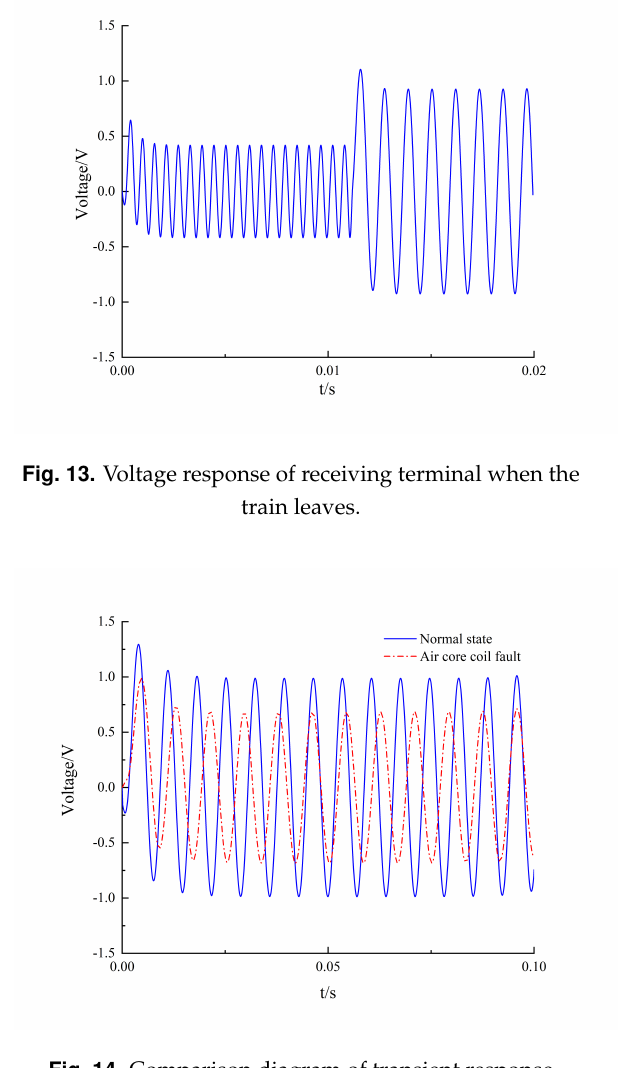
Fig. 14. Comparison diagram of transient response between normal state and fault